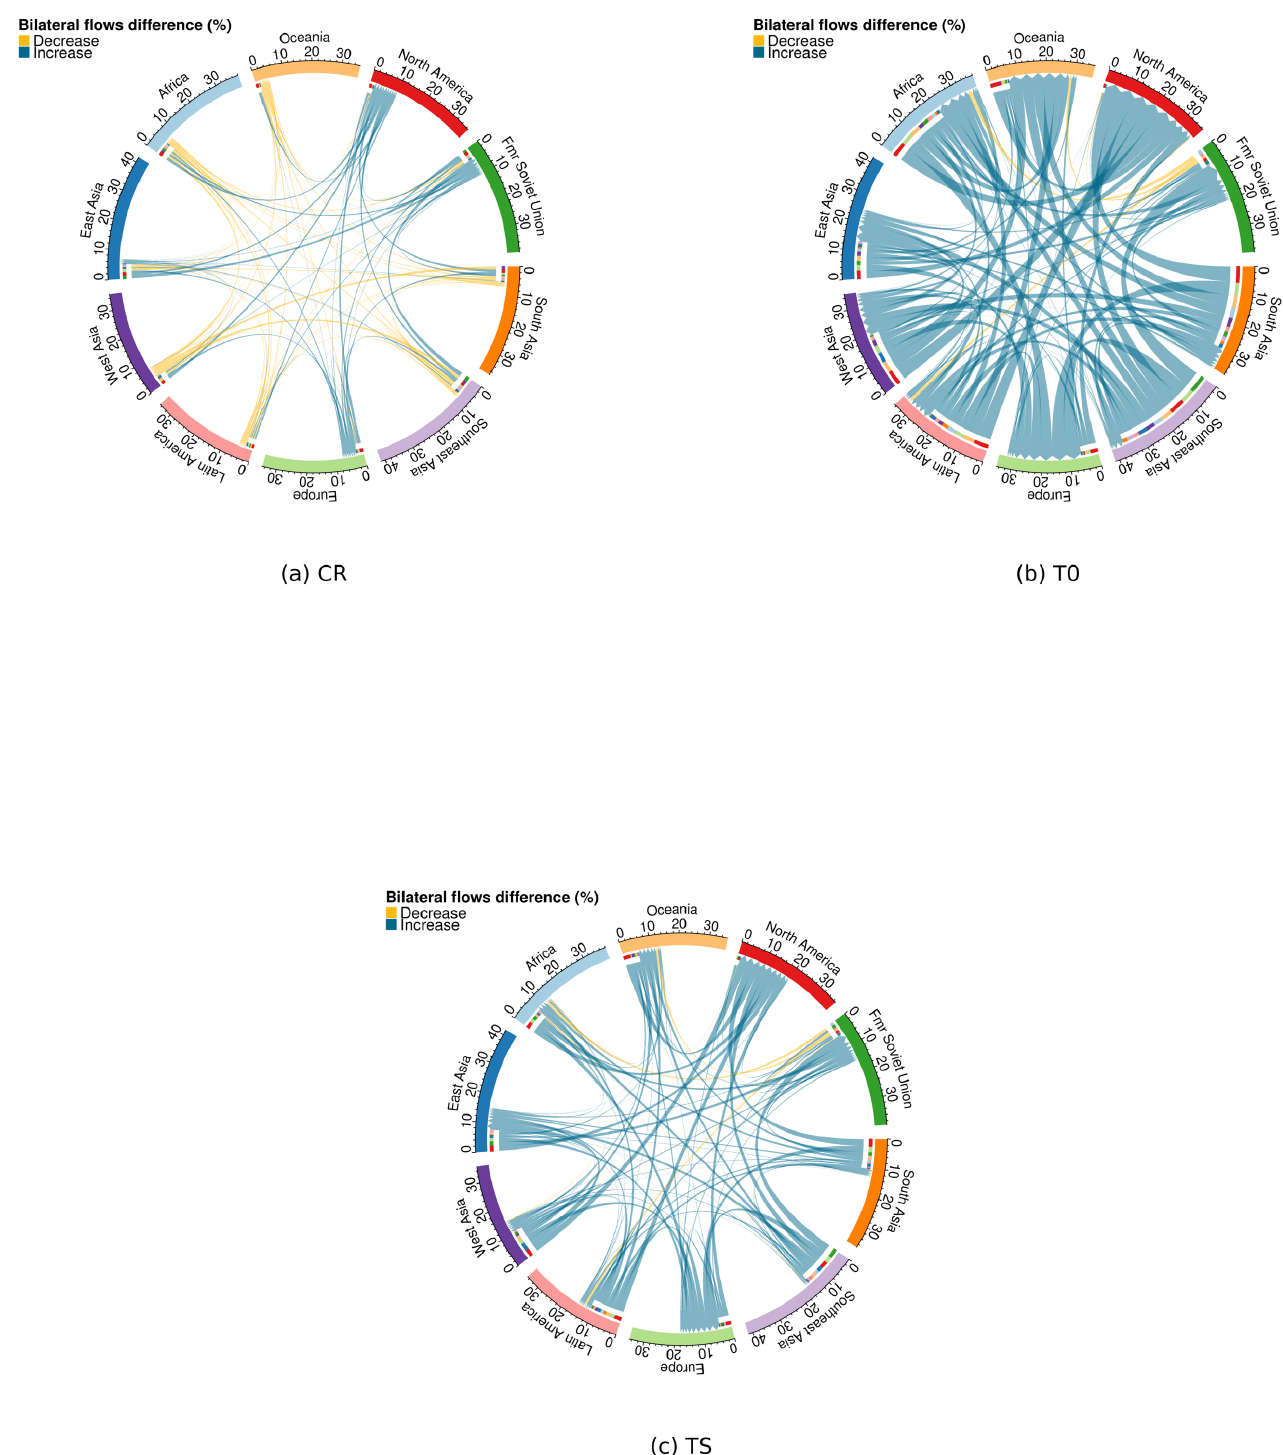
Fig 6. Impact of climate change on bilateral migration flows between ten major world regions under SSP5–8.5 scenario, short-term impact method and the three assumptions regarding emigration rates.